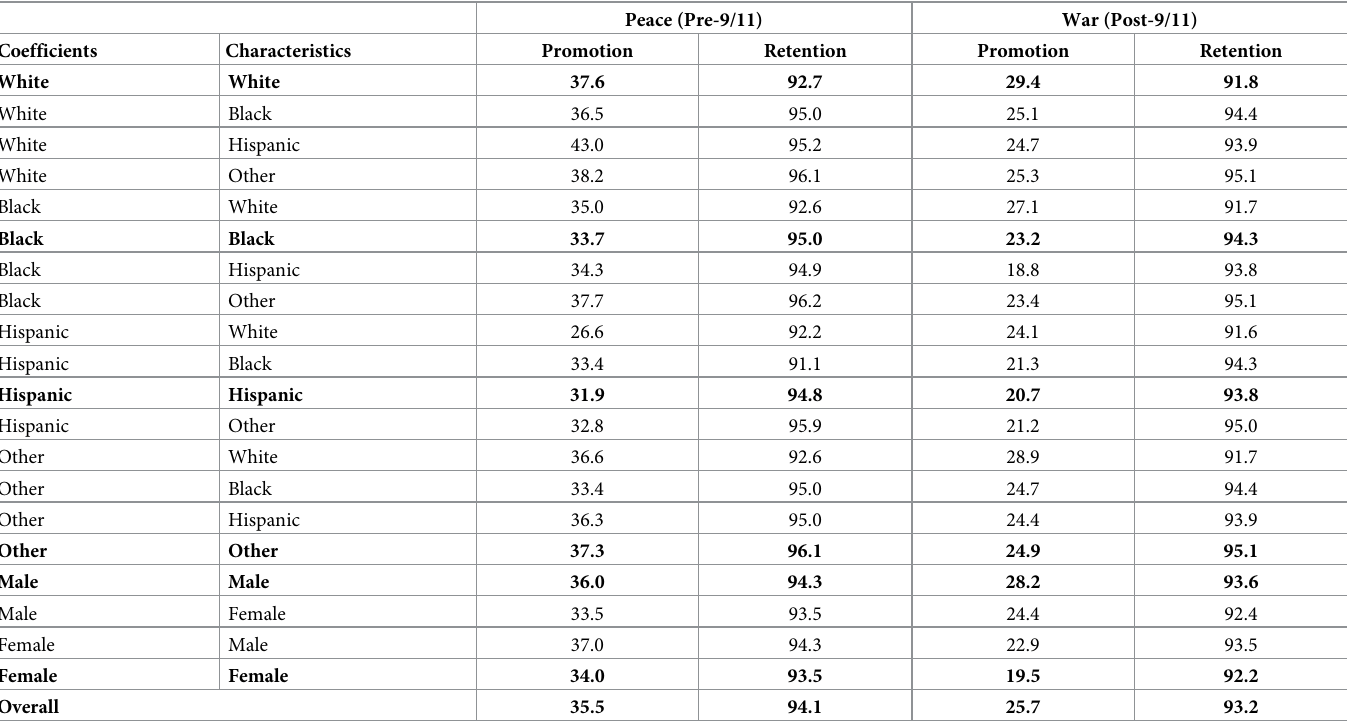
Table 3. Predicted probabilities (%) by race and sex for E5